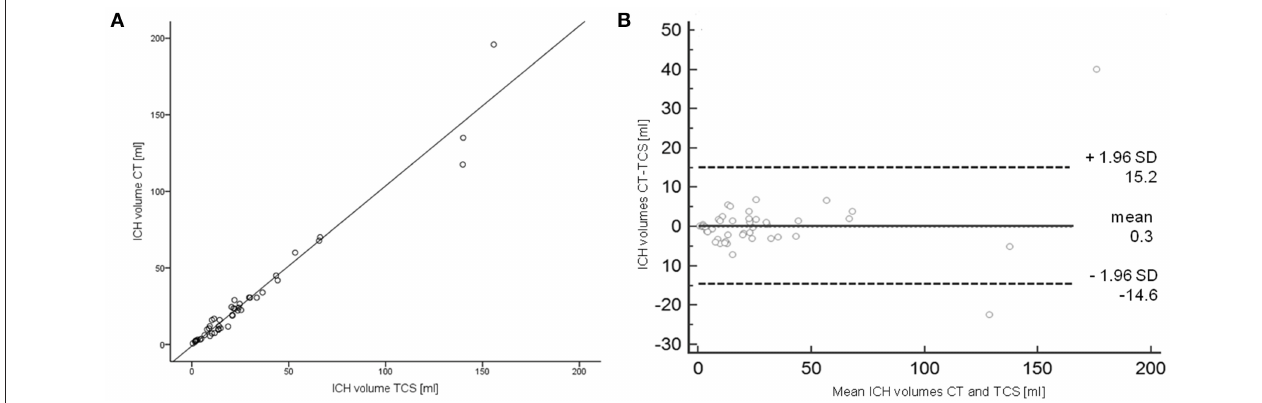
FIGURE 2 | Correlation and Bland-Altman-analysis of TCS- and CT-data. (A) Linear correlation of hemorrhage-volumetry measured via CT and TCS. (B) Bland-Altman-analysis comparing CT- and TCS-volumetry. CT, computed tomography; TCS, transcranial sonography.